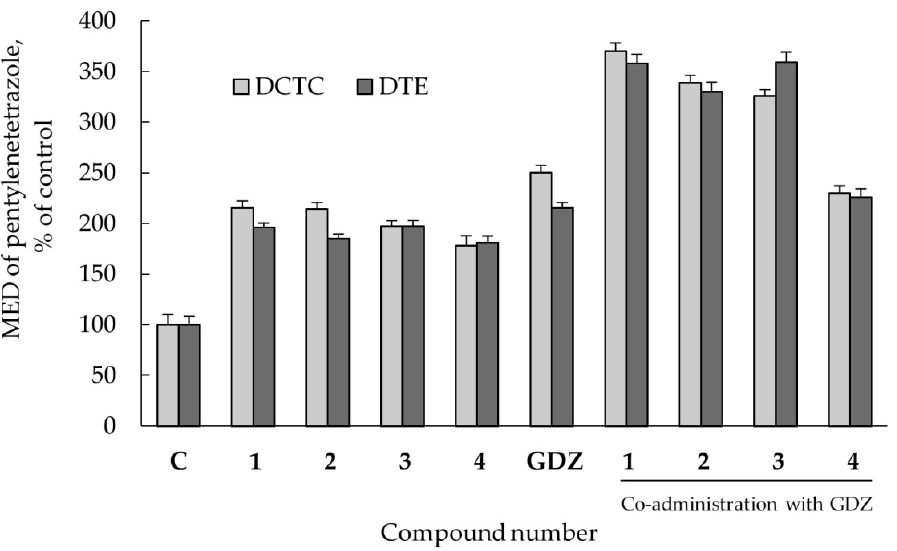
Figure 4. Anticonvulsant activity of compounds 1 – 4 , GDZ and mixtures of GDZ with 1 – 4 at 3 h after oral administration. For all groups p < 0.01 compared with control. One-way analysis of variance (ANOVA) followed by Tukey’s post hoc comparison.